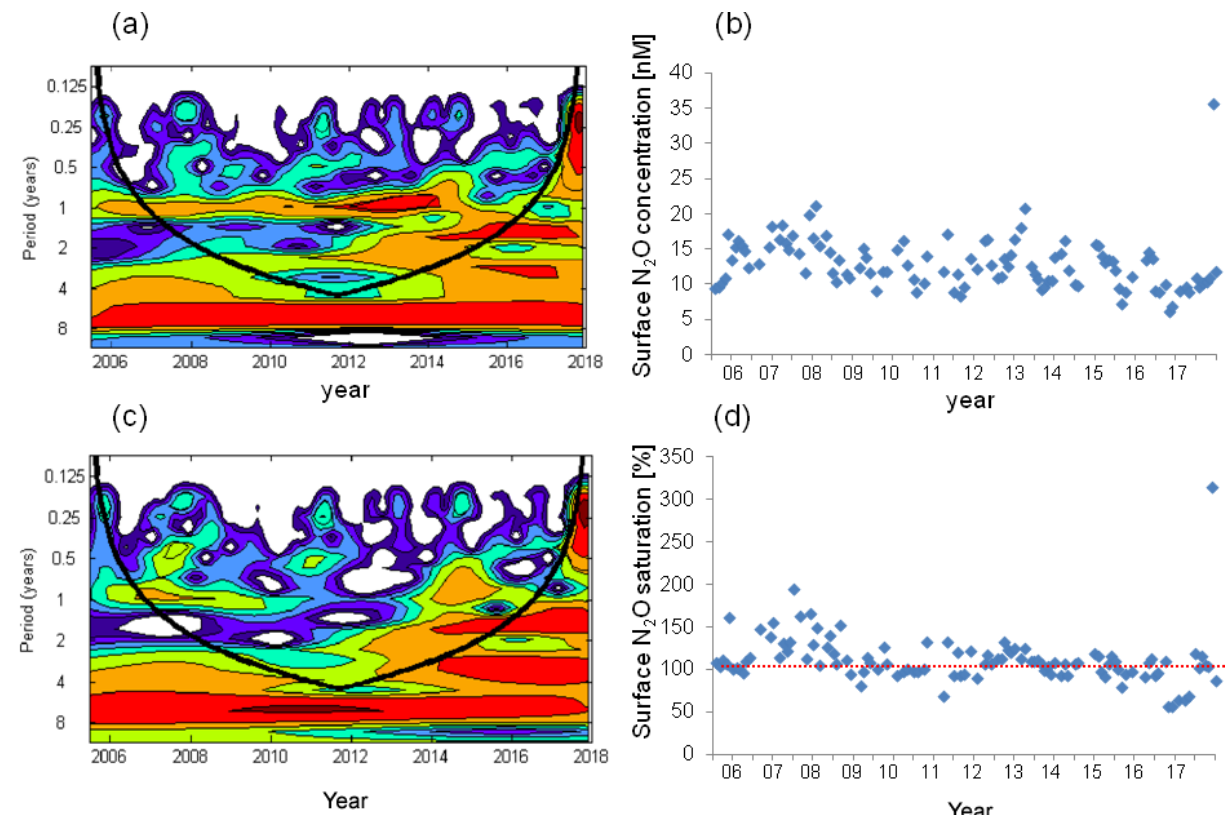
Figure 7. Wavelet analysis and the variation in surface N 2 O concentrations (a, b) and surface N 2 O saturations (c, d) . The dashed red line in (d) indicates the saturation of 100%.